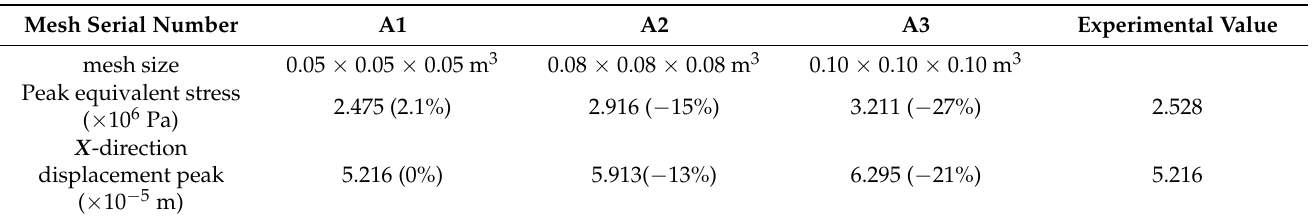
Table 4. Comparison of peak equivalent stress and peak displacement in X -direction at different mesh